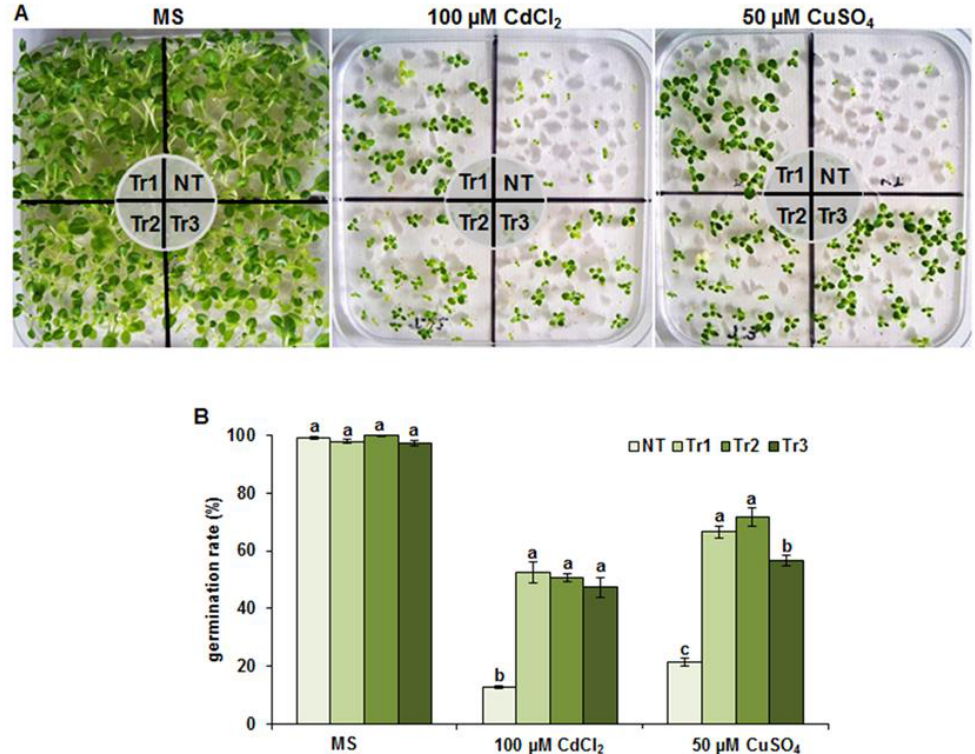
Figure 3. Effect of Cd (100 µ mM) and Cu (50 µ mM) stress on seed germination and plant phenotype in the transgenic tobacco lines (Tr1, Tr2, and Tr3) overexpressing LmTrxh2 . ( A ) Twenty days after seed germination; ( B ) the seed germination rates of the transgenic and NT plants. The means denoted by the same letter did not differ significantly at p < 0.05.